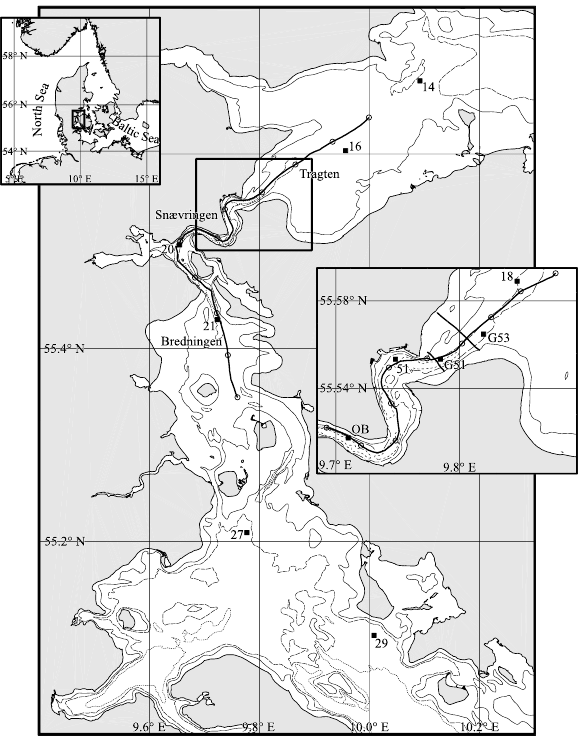
Figure 1. Map of the Little Belt with insets showing the three straits connecting the Baltic Sea and the North Sea (upper left) and a de- tailed view of the narrow part and the contracting part to the north (right). The depth contours indicate 10m (solid), 20m (dashed), and 30m (dotted). The original place names that are briefly mentioned in the text are shown. The locations of the stations from which data have been used are shown (solid squares), OB implying the Old Bridge. The two along-strait survey lines, along which every 2 and 5km are marked (circles), are where the density transects in Figs. 2 and 4 were made. The two cross-strait survey lines just north of the narrow part are where the density transects in Fig. 5 were